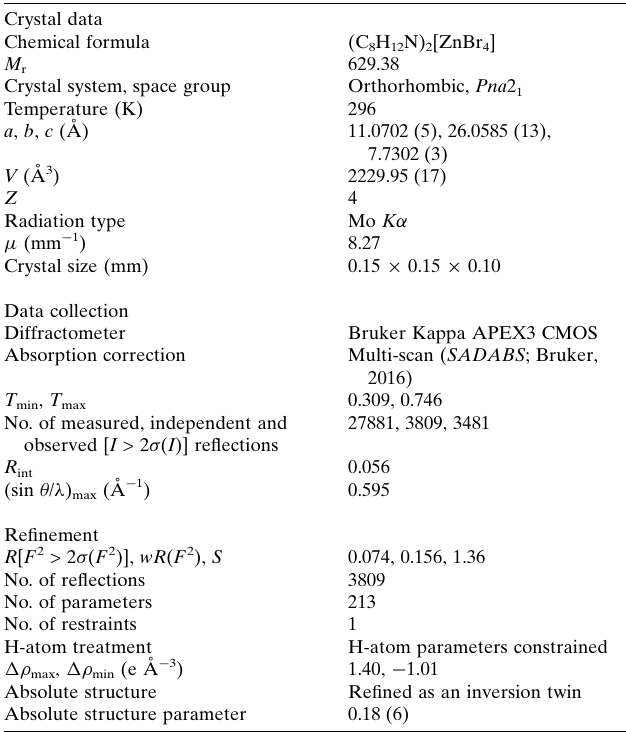
Table 2 Experimental details. Crystal data Chemical